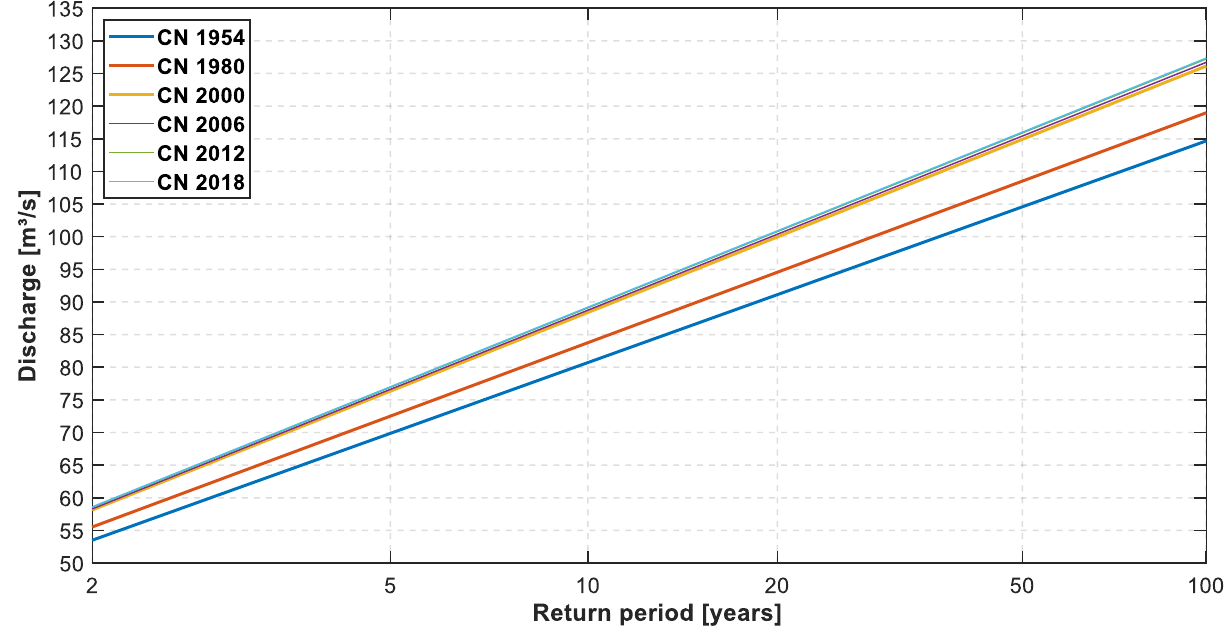
Figure 11. Relationship between discharge and return period at different CN conditions over the section of the Seveso River basin closed at Bovisio-Masciago. Table 3. Return period and probability of yearly exceedance the second warning threshold of 90 m 3 /s at given CN conditions.